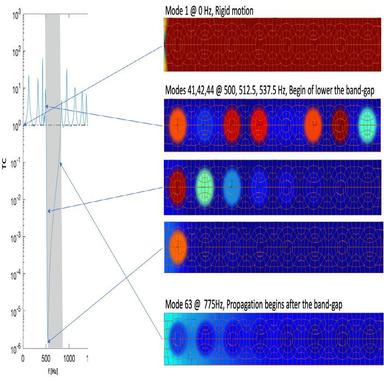
Detail of the transmission curve for a x-polarized plane wave, showing most important modes shapes.